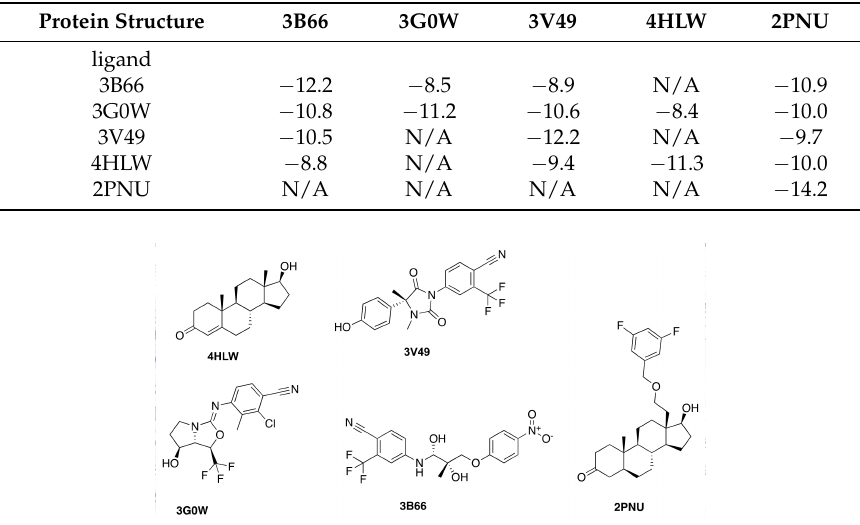
Figure 1. 2D Structures of androgen receptor (AR) agonists bound to the five AR crystal structures.